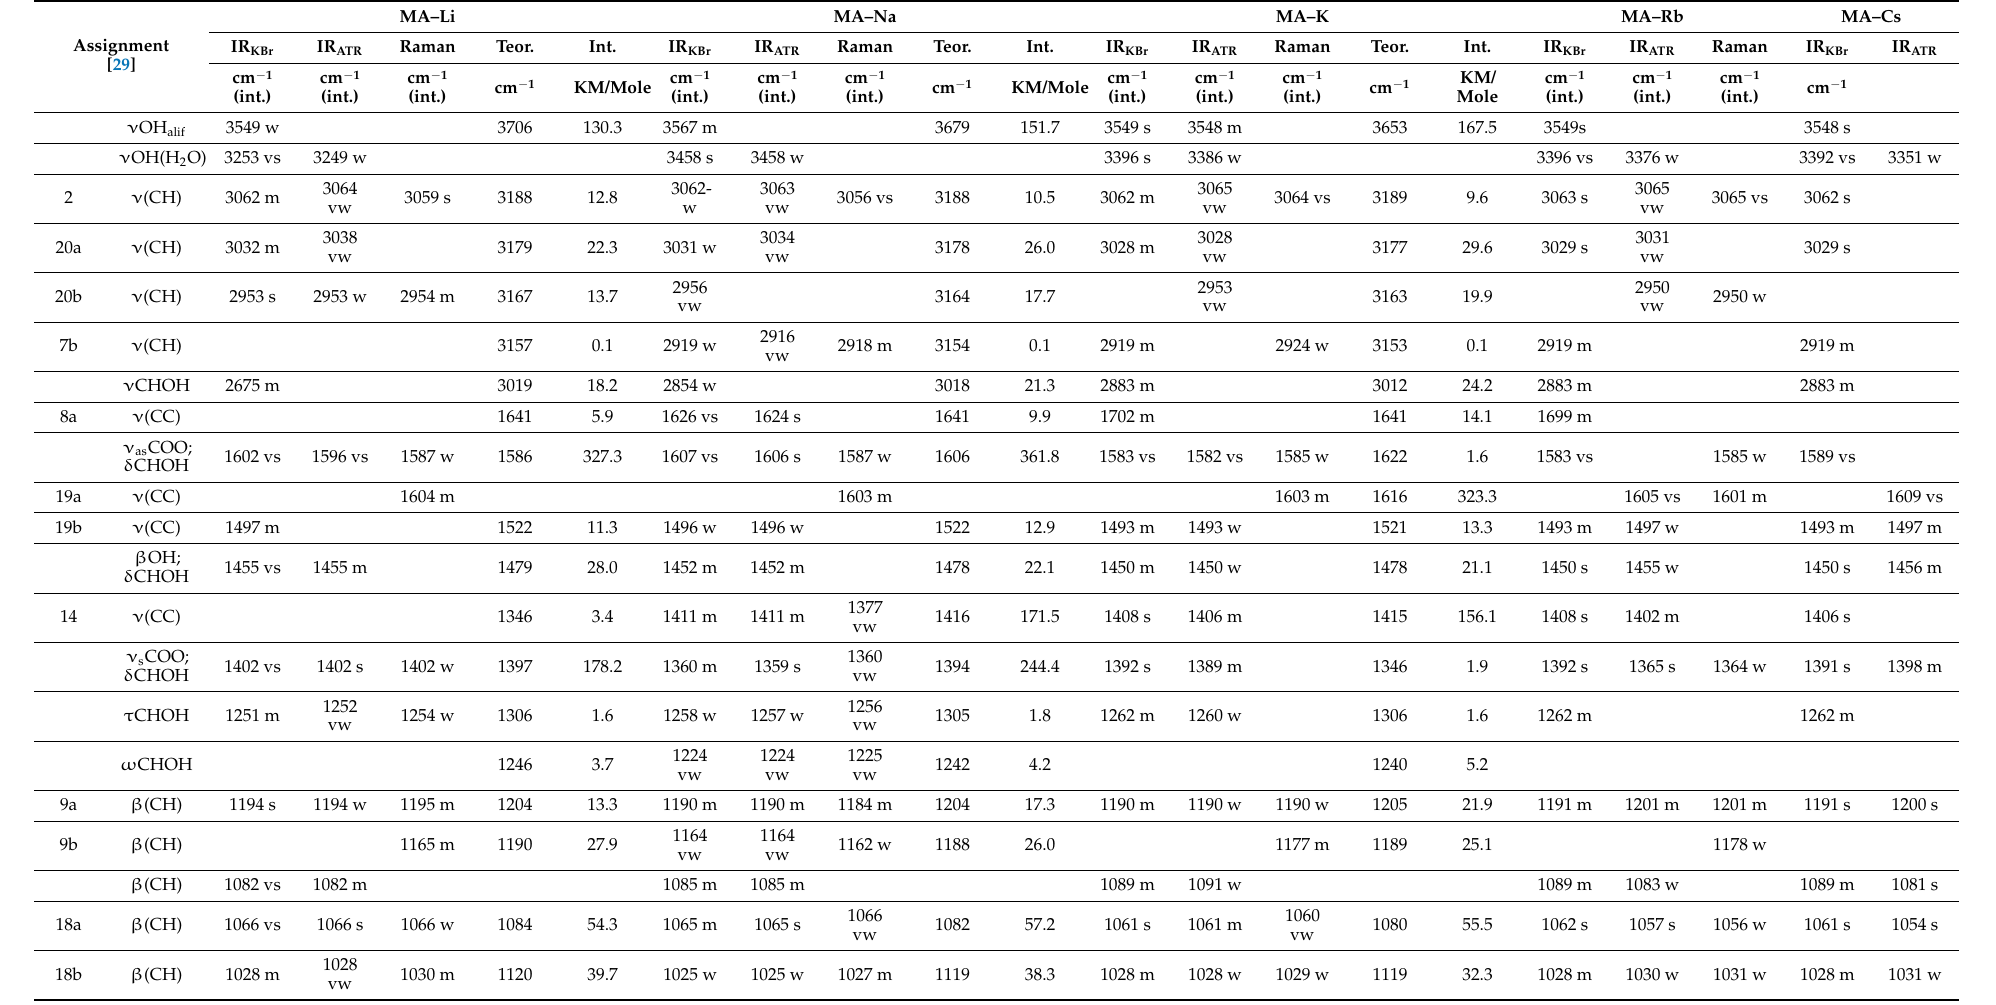
Table 1. The wavenumbers (cm − 1 ) and assignments of bands from the FT-IR and FT-Raman spectra of lithium, sodium, potassium, rubidium, and cesium of